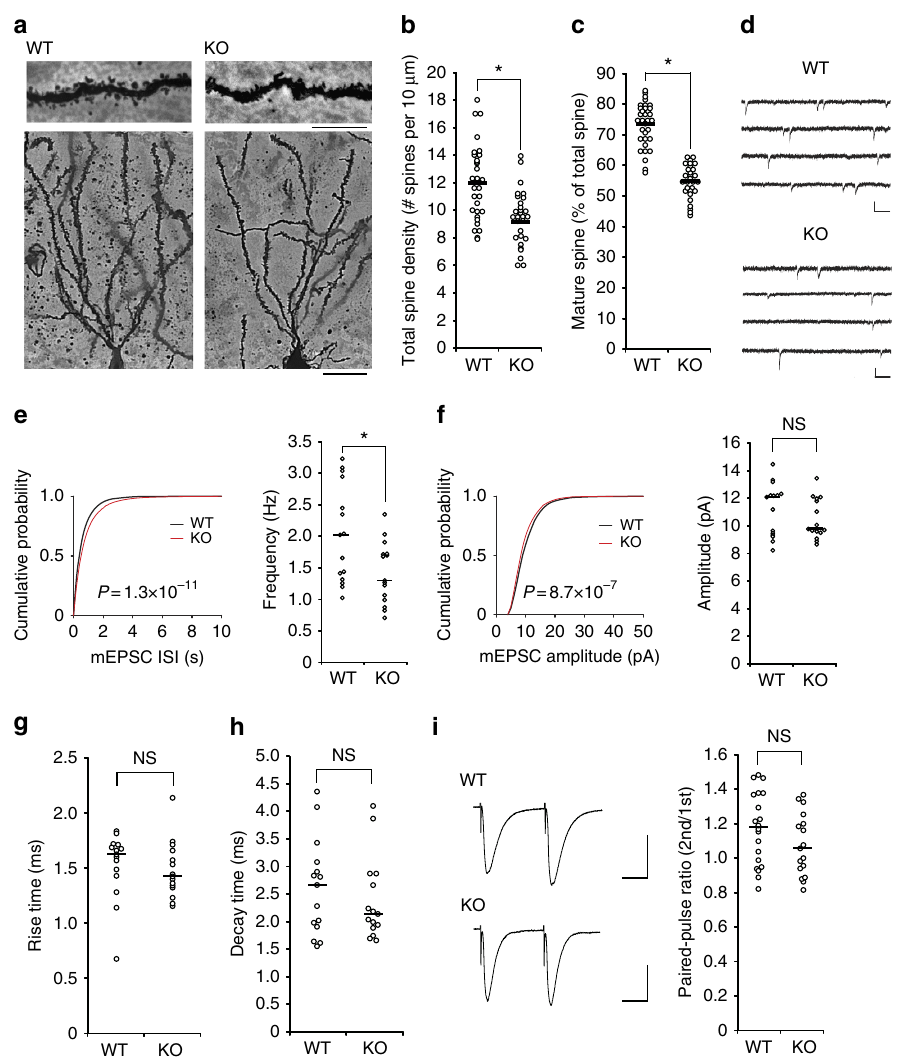
Figure 2 | Impaired spine development in ARHGAP33 KO mice. ( a – c ) Decreased total and mature spine densities in ARHGAP33 KO mice. Examples of Golgi staining of granule cells in the hippocampal dentate gyri from 12-week-old ARHGAP33 KO and WTmice ( a ). Scale bars, 10 m m. Z-stacks were imaged, and individual spines were measured (WT, n ¼ 33 cells, KO, n ¼ 29 cells; each n ¼ 4 mice; total spine density, P ¼ 4.4 (cid:2) 10 (cid:3) 5 ; percentage of mature spines, P ¼ 7.7 (cid:2) 10 (cid:3) 17 , one-way ANOVA; b , c ). * P o 0.05. Bars show mean values. Note that dendritic protrusions with widths larger than half their length were classified as mature spines 49 . ( d – h ) Decreased mEPSC frequency and amplitude in ARHGAP33 KO dentate gyrus granule cells. Representative traces of mEPSCs obtained from hippocampal slices of 12-week-old WT and ARHGAP33 KO mice ( d ). Scale bar, 10pA, 100ms. Cumulative probability plot and summary of average mEPSC frequency and amplitude of the same neurons ( e – h ). mEPSC frequency (cumulative probability plot, WT, n ¼ 2,937 events, KO, n ¼ 2,139 events, P ¼ 1.3 (cid:2) 10 (cid:3) 11 , Kolmogorov–Smirnov test; average (scatterplot), WT, n ¼ 15 cells, KO, n ¼ 15 cells, P ¼ 0.017, Mann–Whitney U -test; e ); mEPSC amplitude (cumulative probability plot, WT, n ¼ 2,937 events, KO, n ¼ 2,139 events, P ¼ 8.7 (cid:2) 10 (cid:3) 7 , Kolmogorov–Smirnov test; average (scatterplot), WT, n ¼ 15 cells, KO, n ¼ 15 cells, P 4 0.05, Mann–Whitney U -test; f ); rise time ( g ) and decay time ( h ; WT, n ¼ 15 cells, KO, n ¼ 15 cells, P 4 0.05, Mann–Whitney U -test). * P o 0.05. Bars in the summary plots show median values. ( i ) No change in the paired-pulse ratio of evoked EPSCs from ARHGAP33 KO dentate gyrus granule cells. Representative traces of EPSCs (left). Scale bars, 100pA, 20ms. Summary graph showing the ratio of the second to the first EPSC amplitude (WT, n ¼ 20 cells; KO, n ¼ 17 cells, P 4 0.05, Mann–Whitney U -test; right). NS, not